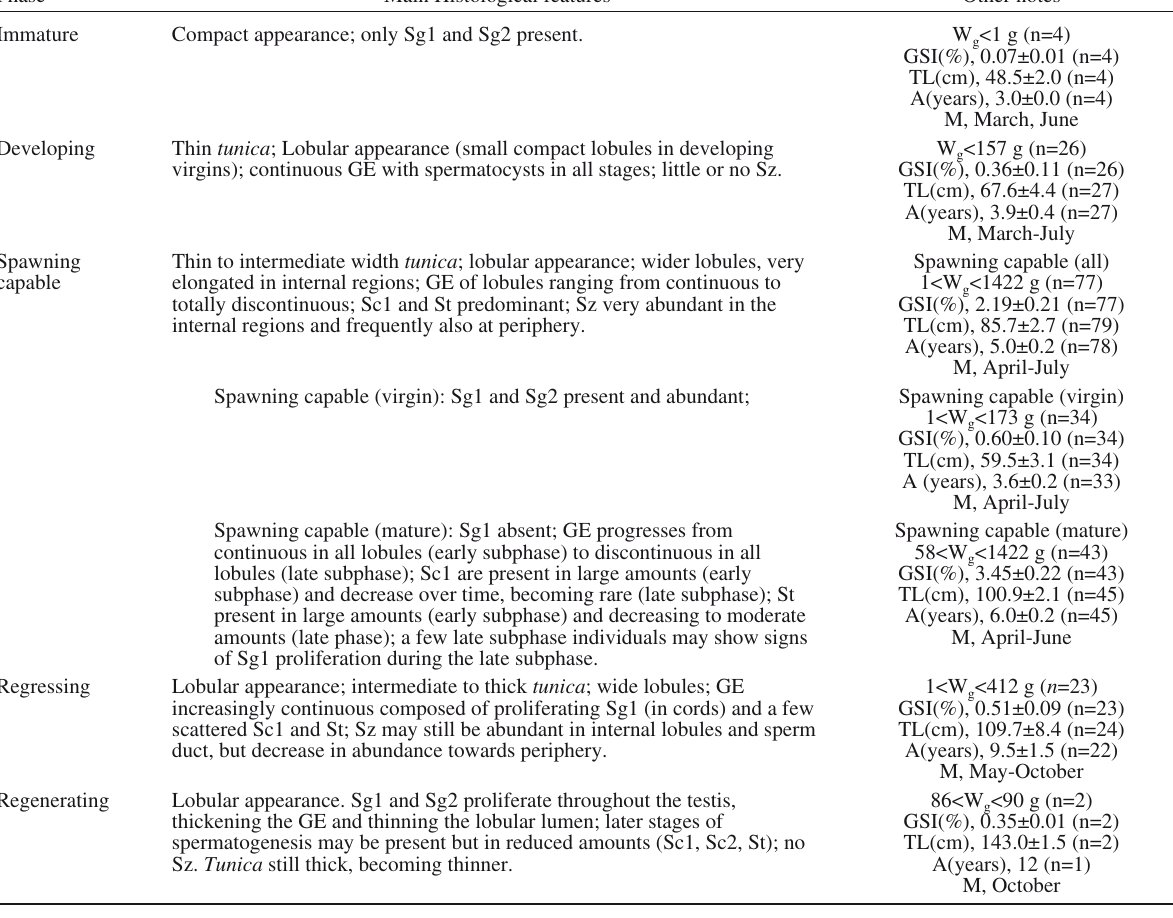
Table 4. – Histological corroboration of the gross anatomical scale. Numbers displayed are percentages of column totals. Anatomical class